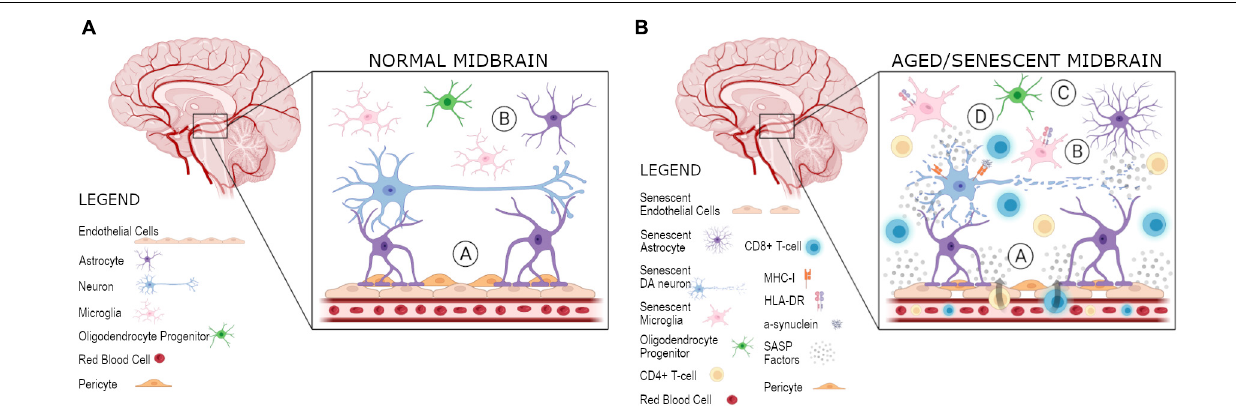
FIGURE 1 | Proposed model for spreading of senescence and local inflammation in the midbrain. Various cell types, including DA neurons, microglia, astrocytes, and OPCs, are present in the midbrain. (A) At the BBB there is a coupling of the neurovascular unit in a normal midbrain, composed of the brain vasulature containing endothelial cells, as well as astrocytes, and their connections to neurons: (A) an impermeable BBB of normal integrity is present and (B) microglia and astrocytes are present for surveillance and support of DA neurons, respectively. (B) In an aged/senescent midbrain, there are three plausible hypotheses for the spreading of cellular senescence and its role in the uncoupling of the neurovascular unit and local inflammation: (A) endothelial cells at the BBB become senescent and release SASP factors, resutling in a recruitment of T-cells, which are able to enter the midbrain as a result of weakened BBB integrity, (B) midbrain DA neurons become senescent in PD and their secreted SASP factors are able to spread senescence to other cell types, including astrocytes, microglia, OPCs, and/or endothelial cells, which eventually leads to the weakening of the BBB and recruitment of adaptive immune cells, or (C) some other cell type in the midbrain, astrocytes, microglia, OPCs, or endothelial cells, become senescent and act negatively on surrounding cells by initiating the paracrine spreading of senescence to other cell types, including DA neurons, and BBB integrity is eventually impaired allowing for T-cell infiltration, as observed in PD. Specifically, HLA-DR + microglia are present in the case of neurodegeneration as an additional marker of T-cell infiltration. In turn, (D) the MHC-I presentation of α -synuclein as an antigen allows for T-cells present in the midbrain to become activated. These activated T-cells can then act to kill DA neurons as seen in PD. Created with BioRender.com.